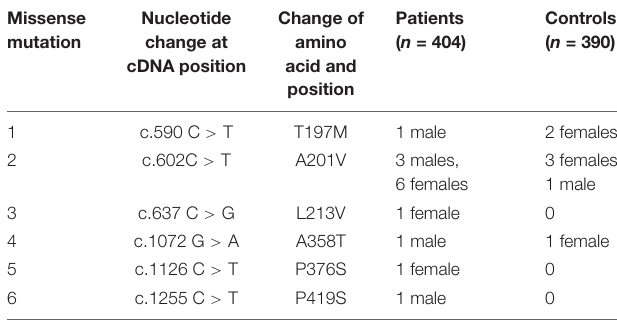
TABLE 2 | Rare missense mutations identified in this